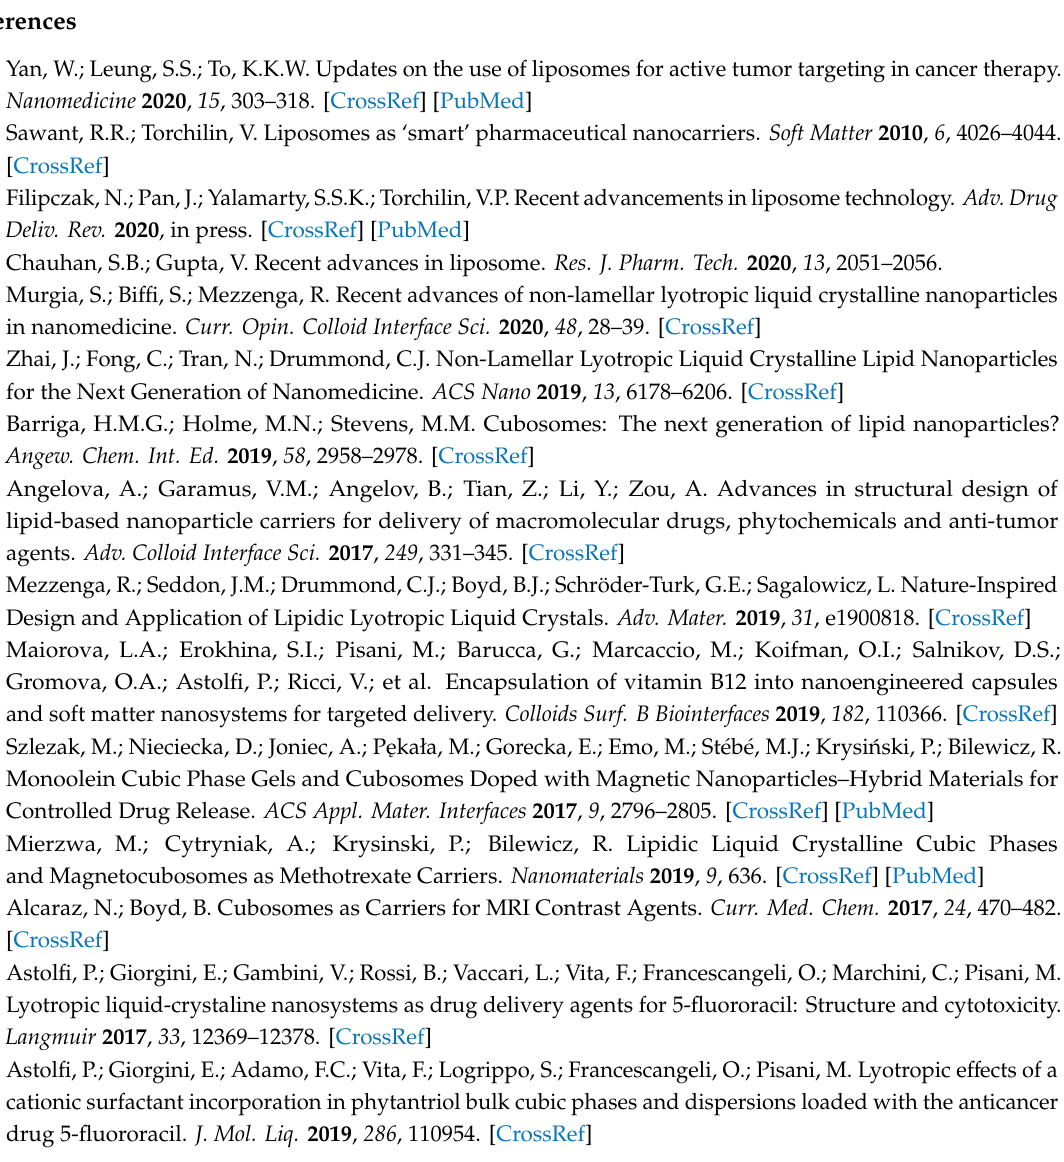
Figure S1: 1 H NMR of GMO / F127 in CDCl 3 , Figure S2: 1 H NMR of C-I in CDCl 3 , Figure S3: 1 H NMR of C-II in CDCl 3 , Figure S4: 1 H NMR of GMO / F127 / C-I in CDCl 3 , Figure S5: 1 H NMR of GMO / F127 / C-II in CDCl 3 , Figure S6: 1 H NMR of GMO / F127 / C-I in D 2 O, Figure S7: 1 H NMR of GMO / F127 / C-II in D 2 O, Figure S8: 31 P NMR C-I in CDCl 3 , Figure S9: 31 P NMR C-II in CDCl 3 , Figure S10: 31 P NMR of GMO / F127 / C-I in CDCl 3 , Figure S11: 31 P NMR of GMO / F127 / C-II in CDCl 31 P NMR of GMO / F127 / C-I in D 31 P NMR of 3 , Figure S12: 2 O, Figure S13: GMO / F127 / C-II in D 2